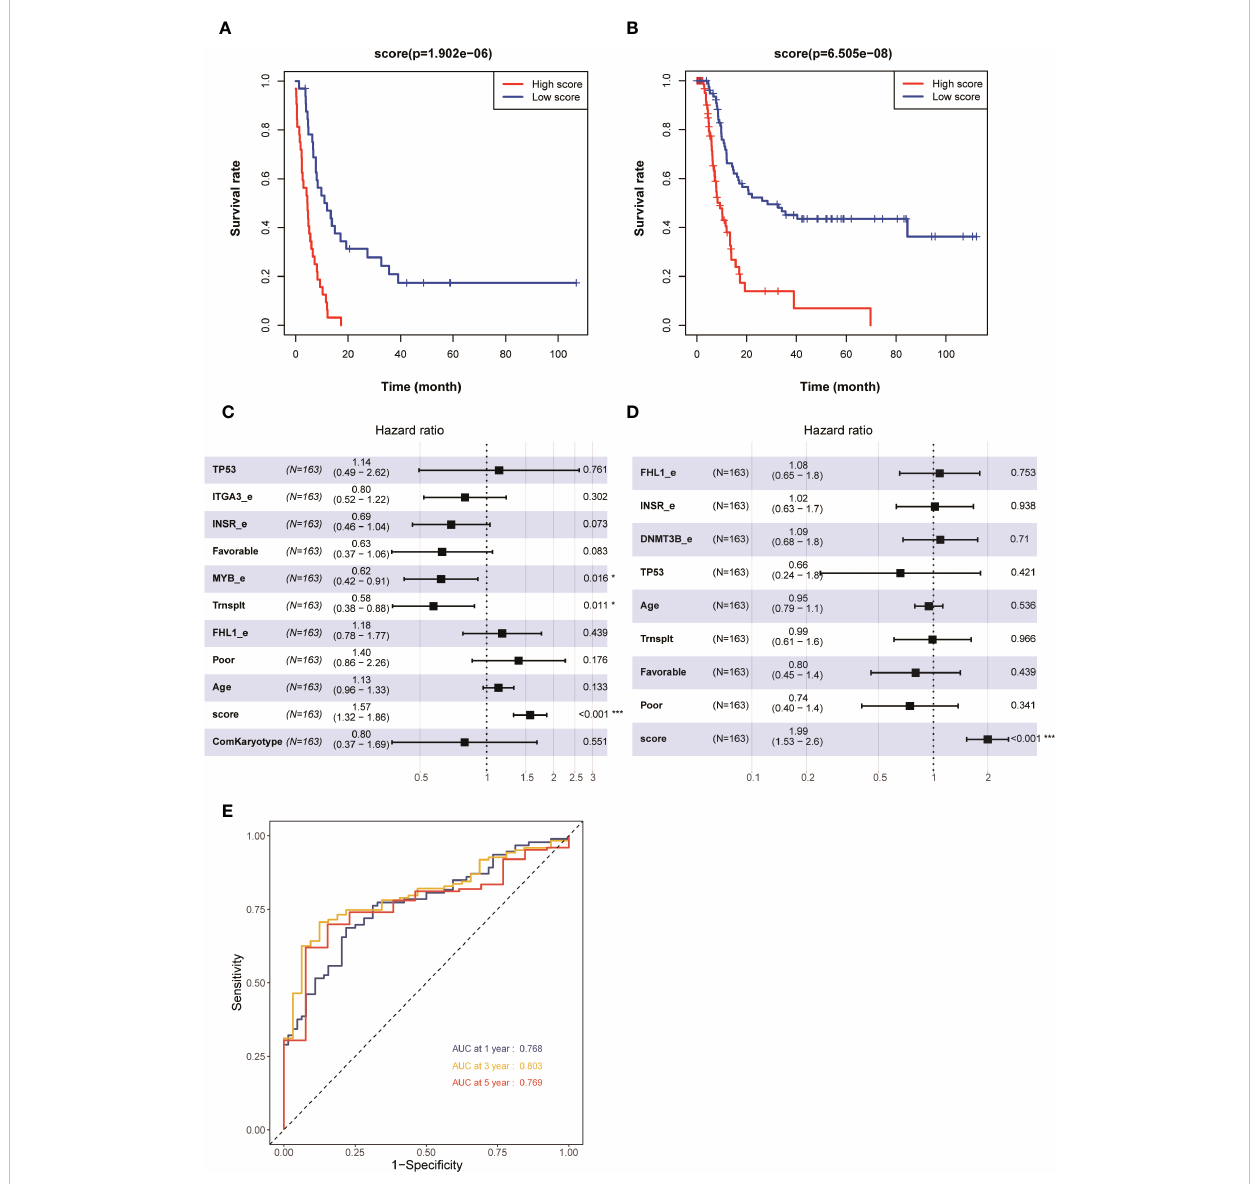
FIGURE 2 Kaplan – Meier survival curves of patients with AML having high and low risk scores in 163 patients with AML (none-m3) in the TCGA database: (A) OS and (B) EFS. Multivariate analyses of clinical outcomes for patients with AML. (C) OS and (D) EFS. (E) ROC curves for predicting 1-, 3-, and 5-year survival in the training set. *p < 0.05, ***p <